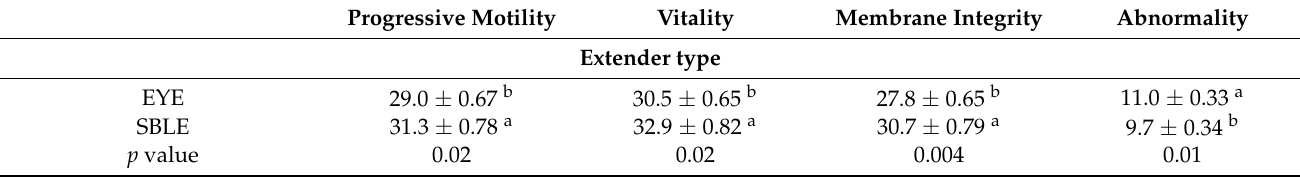
Table 4. Effects of the extender type, bee bread extract (BBE) concentration, and their interaction on the proportion (%) of sperm characteristics after thawing and incubation of ram semen at 37 ◦ C in 5% CO 2 for 2